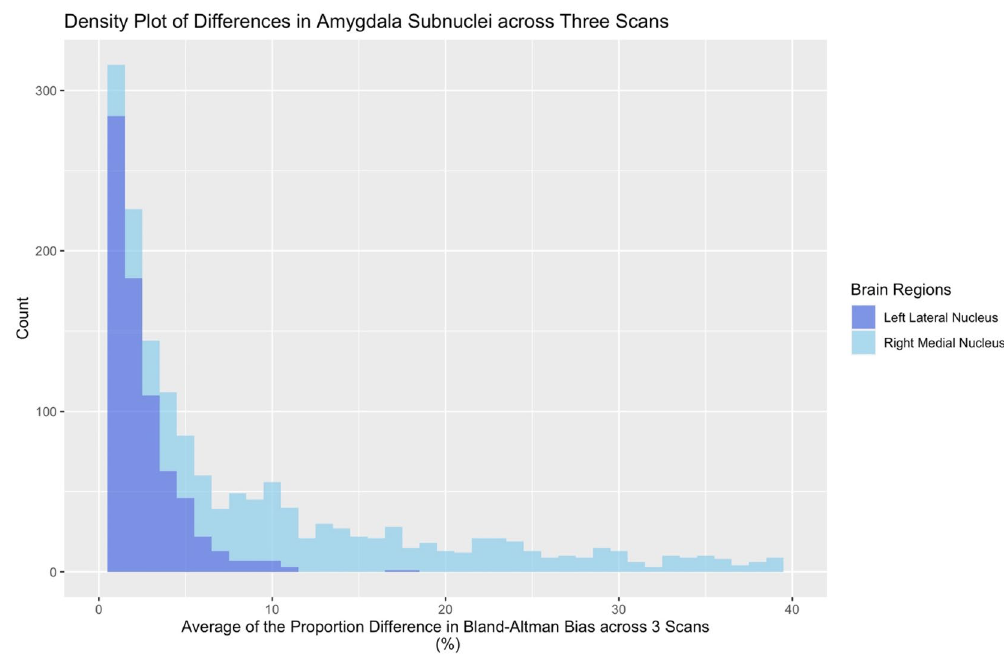
Fig. 4 Bland–Altman plots of the average volume difference estimation across Scan 1, Scan 2, and Scan 3 for the left Lateral Nucleus (dark blue) and right Medial Nucleus (light blue). The horizontal axis indicates the average difference in Bland–Altman “ bias ” (difference between subregional volume output for different scans, as a proportion of a region’s volume), while the vertical axis indicates the number of scans with a given value. Of note, the left Lateral Nucleus has a low degree of bias (as a proportion of the region’s volumes; 0.108%), while the right Medial Nucleus has a fair degree of bias